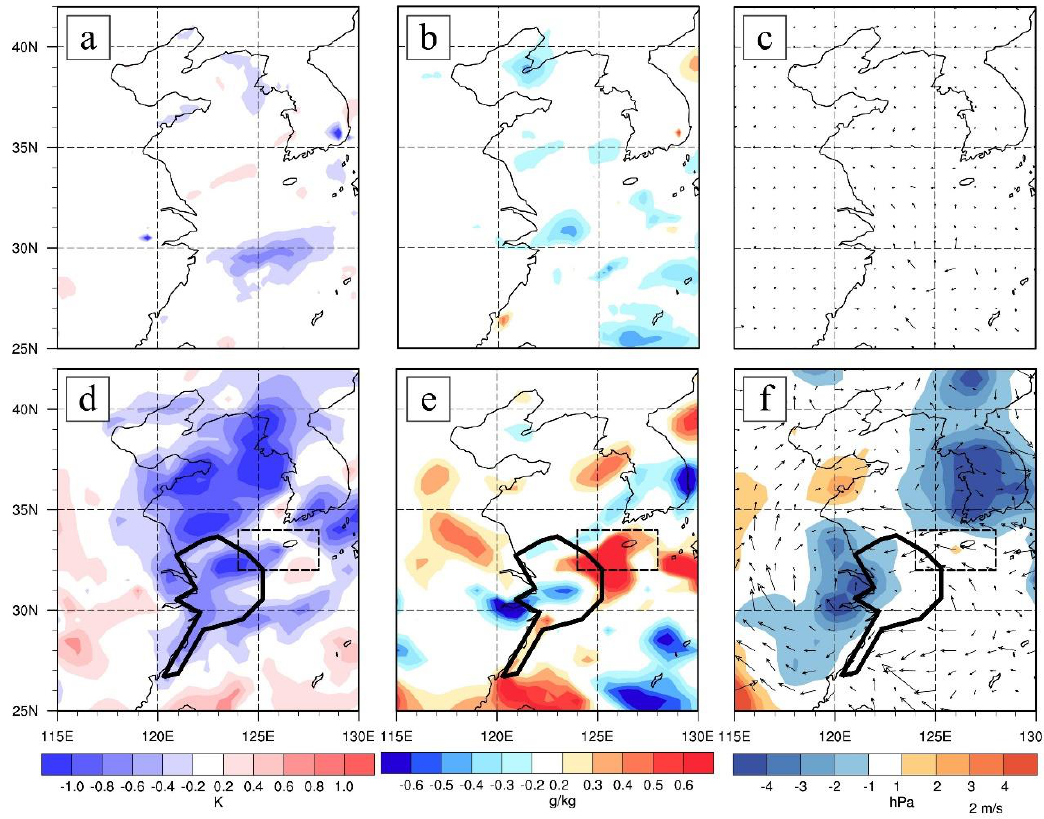
Figure 9. Initial differences of temperature ( a , d ) and mixing ratio ( b , e ) at 1000 hPa, SLP and 10-m wind ( c , f ) between Exp-A2 and Exp-A1 ( a – c ), Exp-A3 and Exp-A1 ( d – f ), respectively. The dashed frame indicates the significant zone, and the closed thick solid line denotes the forecasted sea fog at 1200 UTC 10 April 2009.